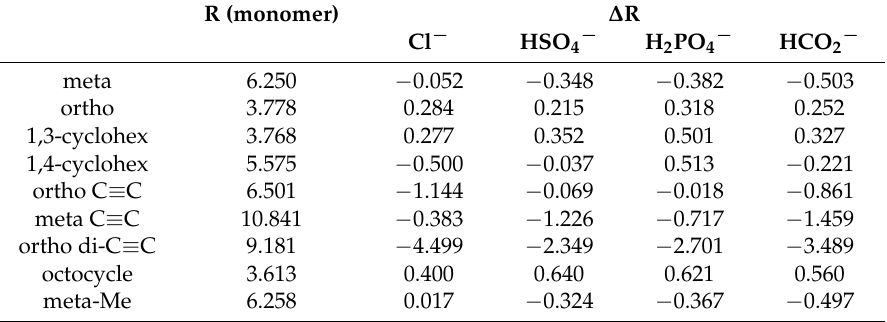
Table 5. R(Sn ··· Sn) distance (Å) in Lewis acid and its change caused by complexation with